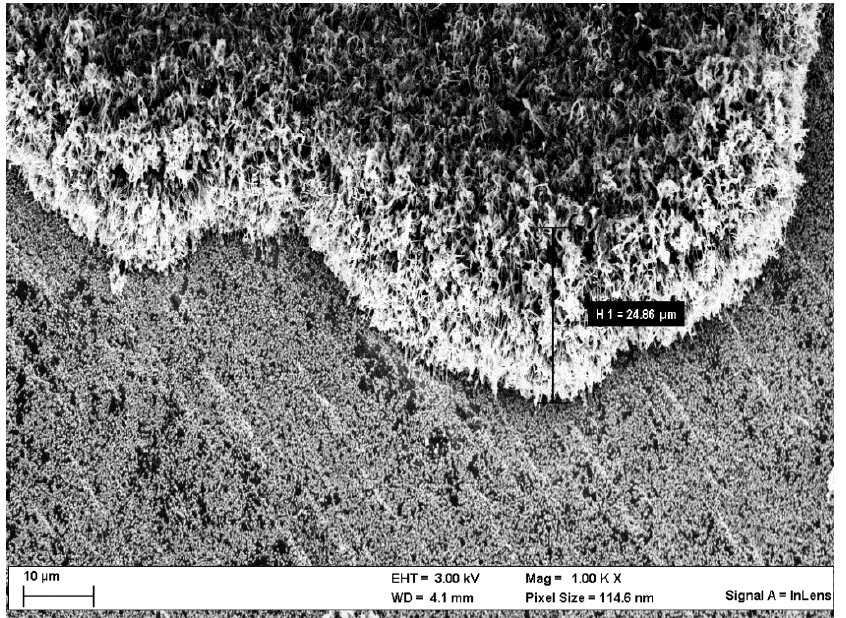
Figure 8. SEM image of lithium metal deposits on a copper foil, immediately after lithium deposition. Lithium was deposited for 360 s with a current density of 1 mA cm − 2 from 1 M in EC:DEC (3:7, by wt.). Additionally the measured height (24.86 µm) of the LiPF 6 lithium metal deposits is